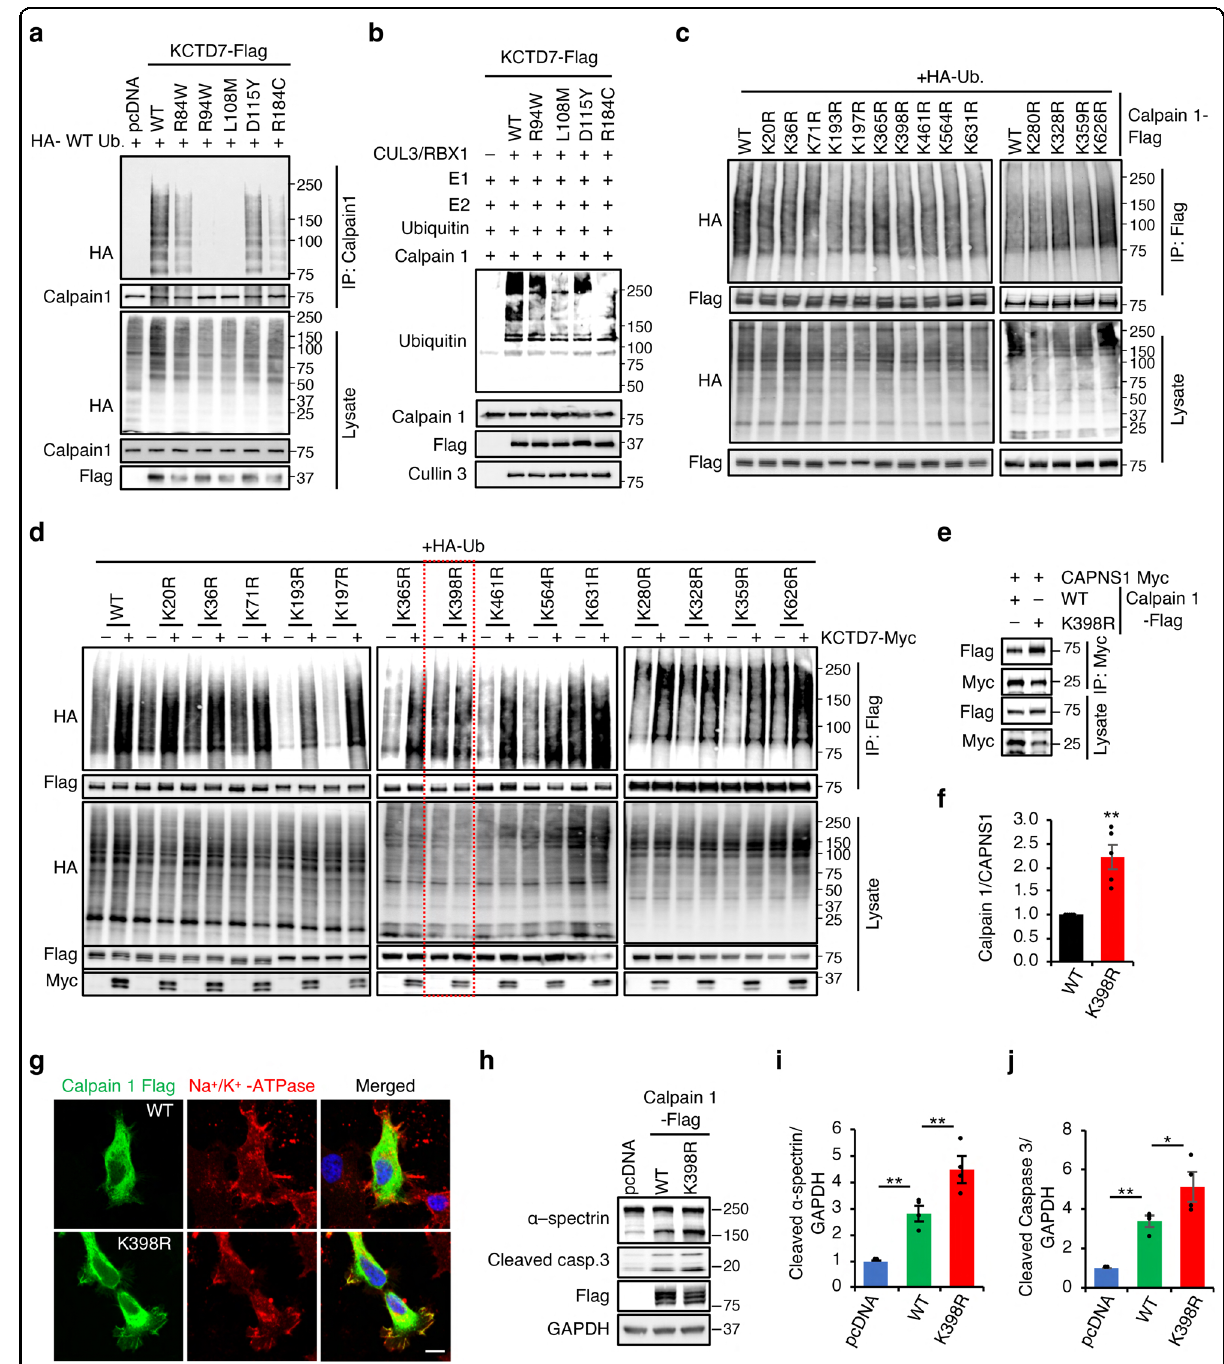
Fig. 4 Calpain mutant resistant to KCTD7-mediated ubiquitination is hyperactive. a In vivo ubiquitination assay for calpain1 performed by expressing WT KCTD7 or pathogenic mutants in HEK293 cells for 36 h. b In vitro ubiquitination assay for calpain 1. c In vivo ubiquitination assay in HEK293 cells for calpain 1 K – R mutants. d In vivo ubiquitination assay for calpain 1 K – R mutants performed with or without KCTD7 in HEK293 cells. e , f Co-IP analysis of Myc-tagged CAPNS1 and Flag-tagged WT calpain 1 or calpain 1-K398R in calpain 1 knock-out HEK293 cells, n = 5. g Confocal microscopy of HeLa cells showing distribution of WT calpain 1 or calpain 1-K398R. Na + /K + -ATPase was used as plasma membrane marker. Scale bar, 10 μ m. h – j WT calpain 1 or K398R mutant were expressed in calpain 1 knock out Hela cells and cleavage of α -spectrin cleavage and caspase 3 were evaluated by immunoblotting, n = 5. Data represent means ± SEM; ∗ P < 0.05, ∗∗ P < 0.01, ns not signi fi